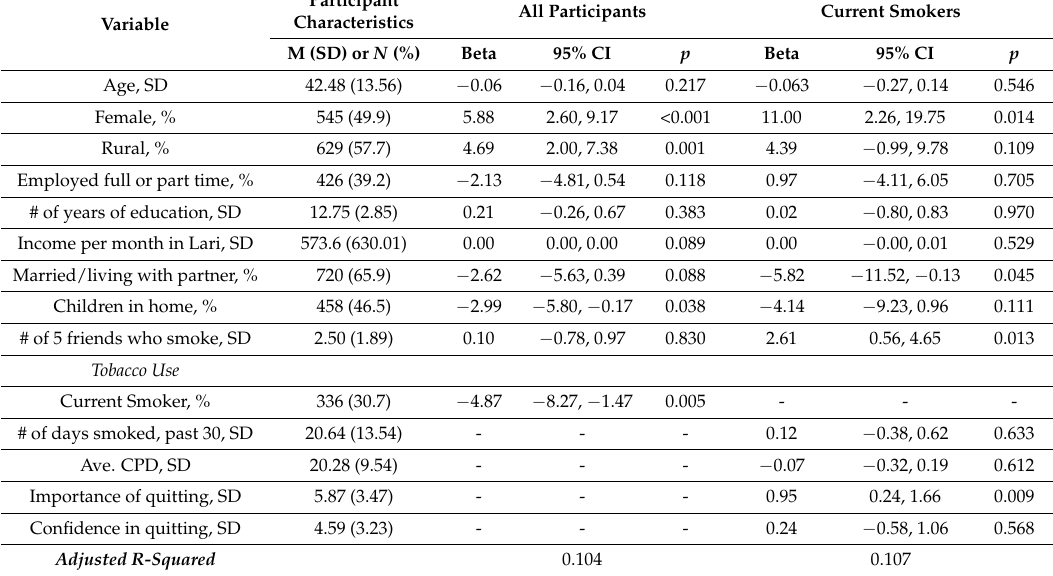
Table 2. Linear regression identifying correlates of reported effectiveness of benign warning labels, Set